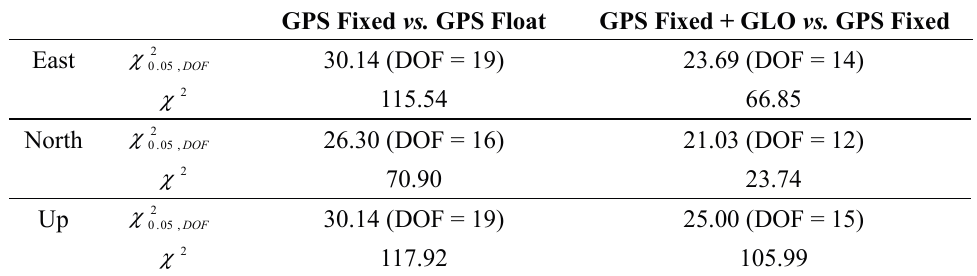
Table 2. Chi-square statistic values of positioning errors in the chi-square two-sample tests. GPS Fixed vs. GPS